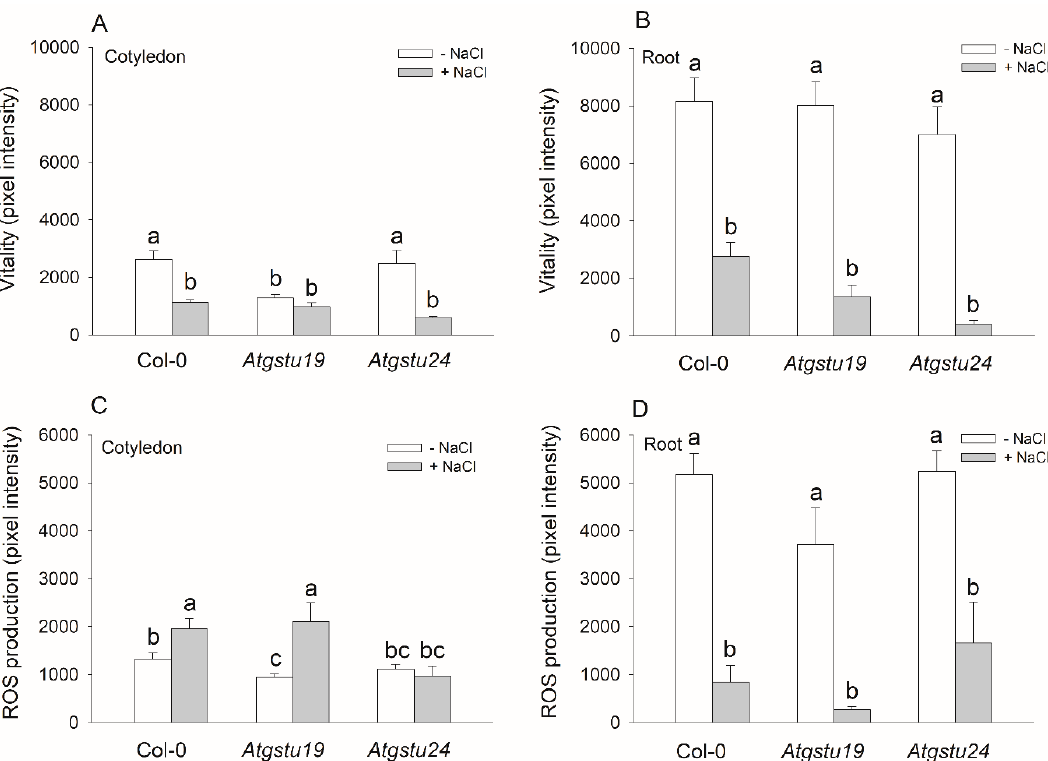
Figure 2. Heat map of 27 A. thaliana tau group glutathione transferase ( GSTU ) gene expression levels. Relative transcript amounts of GSTU genes were determined by RT-qPCR under control conditions (Control) and after 150 mM NaCl treatment (NaCl) in wild-type (Col-0) and GSTU mutant ( Atgstu19 and Atgstu24 ) Arabidopsis plants. For this, the expression of GST genes was normalized first by reference to the average transcript amount of GAPDH2 and actin2 genes, and second to the average transcript amount of each GST genes in wild-type control plants. 2 - ΔΔ Ct data were presented as a heat map. Red colours show repression, while green colours show activation, according to the colour scale bar. The presented data are from one biological replicate. 2.3. The Vitality and ROS Levels of Seedlings Indicated that the Mutants were Able to Cope with the Applied Salt Stress to Some Extent after 48 h The vitality and the level of ROS were investigated in the cotyledons and roots of 16 day old seedlings using fluorescent microscopy with fluorescein diacetate (FDA) and 2’-7’- dichlorodihydrofluorescein diacetate dyes, respectively. While in control conditions, there were no significant differences in the vitality and ROS levels between the wild-type and mutant roots, the FDA pixel intensity of Atgstu19 cotyledons was about half of that in the wild-type, showing the lower vitality of this insertional mutant (Figure 3A,B). Interestingly, the ROS content was less in the Atgstu19 cotyledons than in the Col-0 plants (Figure 3C). These parameters were used to assess the